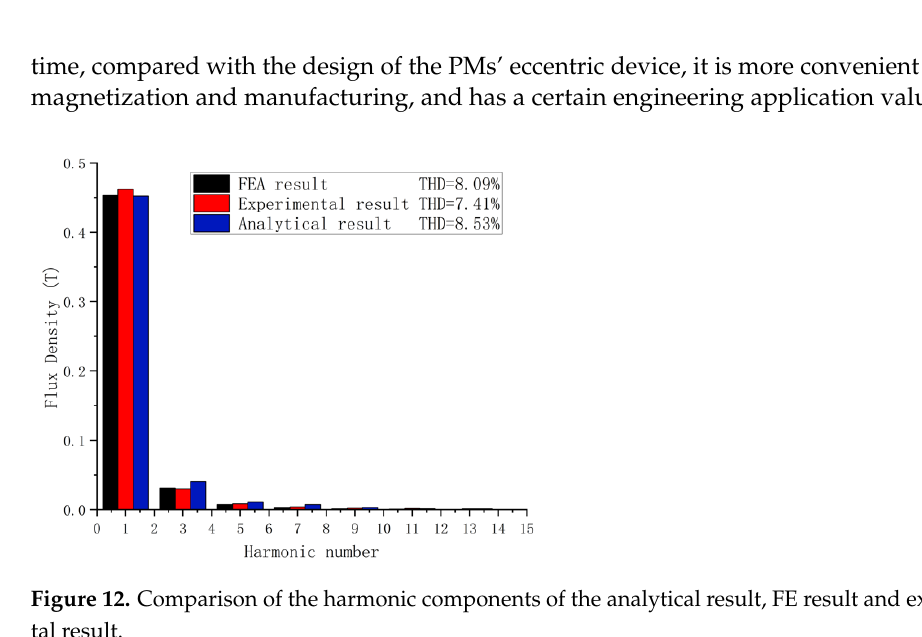
Figure 12. Comparison of the harmonic components of the analytical result, FE result and experi- mental result.